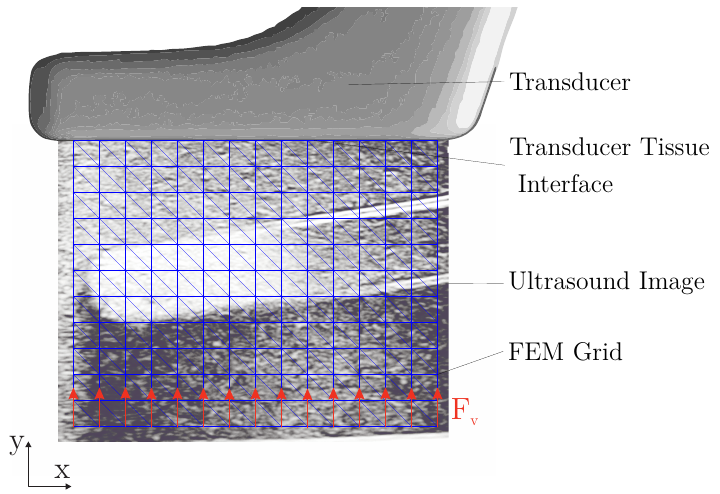
Figure 4. Generated mesh mapped on the US frame. The virtual force F v is